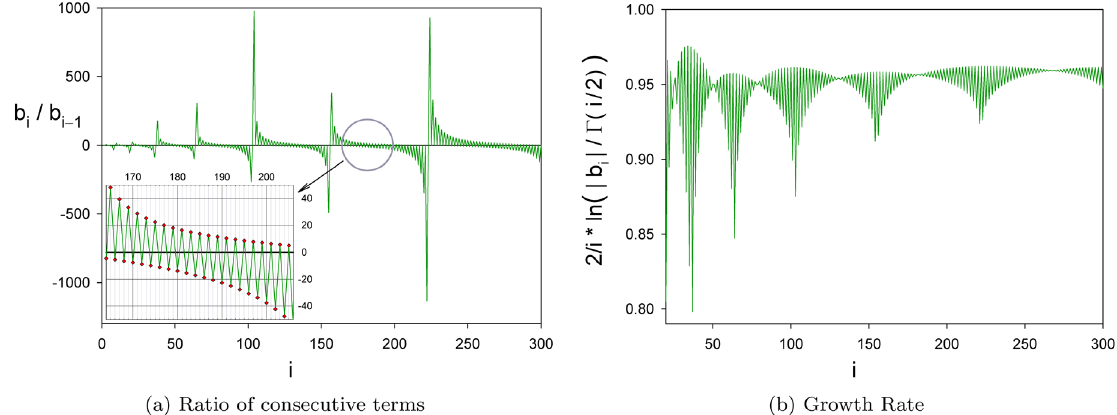
Figure 5. Coefficients b i follows the sign pattern sign alternation of the ratios b i / b i right panel ( b ) depicts the quantity 2 i ln